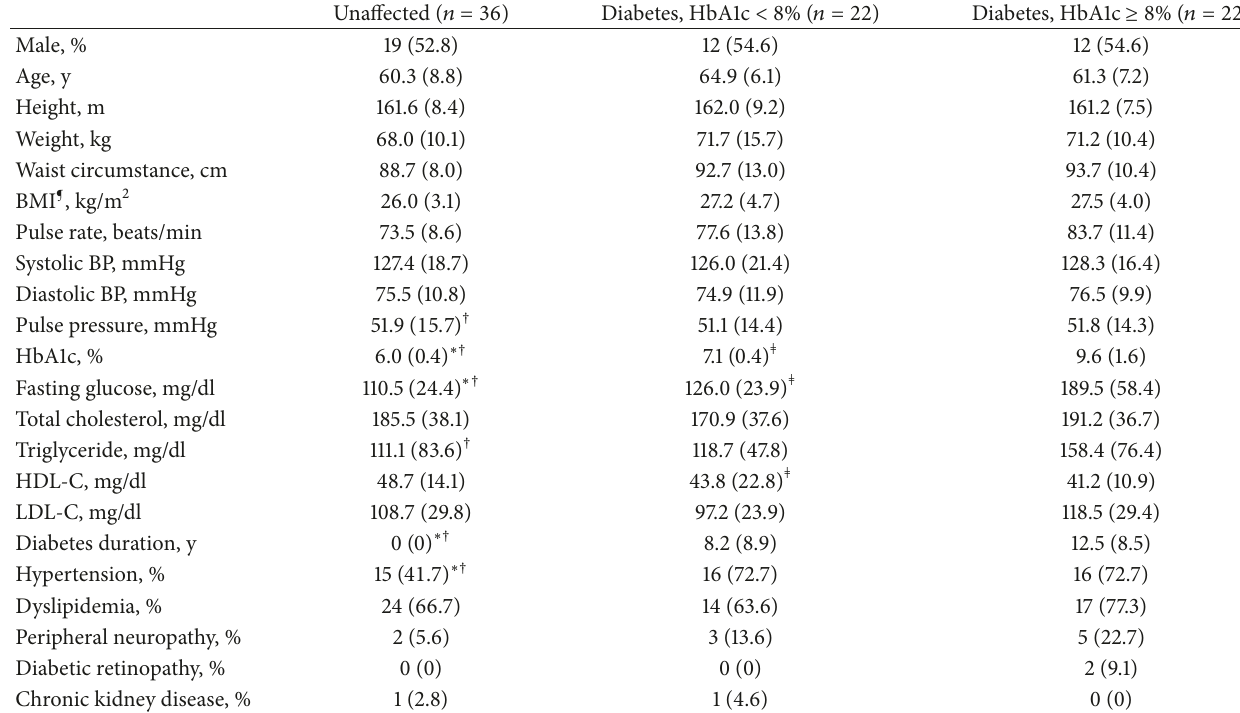
Table 1: Baseline characteristics of nondiabetic participants (unaffected), those with well-controlled diabetes (HbA1c < 8%), and those with poorly controlled diabetes (HbA1c ≥